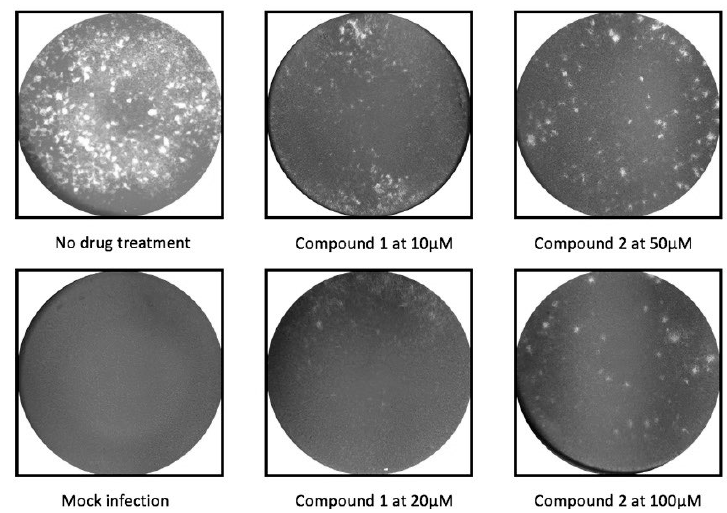
Figure 2. Reduction of plaque formation by Compound 1 at 10 and 20 µ M and Compound 2 at 50 and 100 µ M. Plaque formation developed on BHK-21 cell lines by ZIKV infection with no drug treatment served as a negative control.